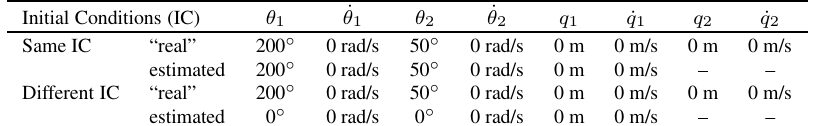
Table 1 Initial condition assumed in the numerical simulations